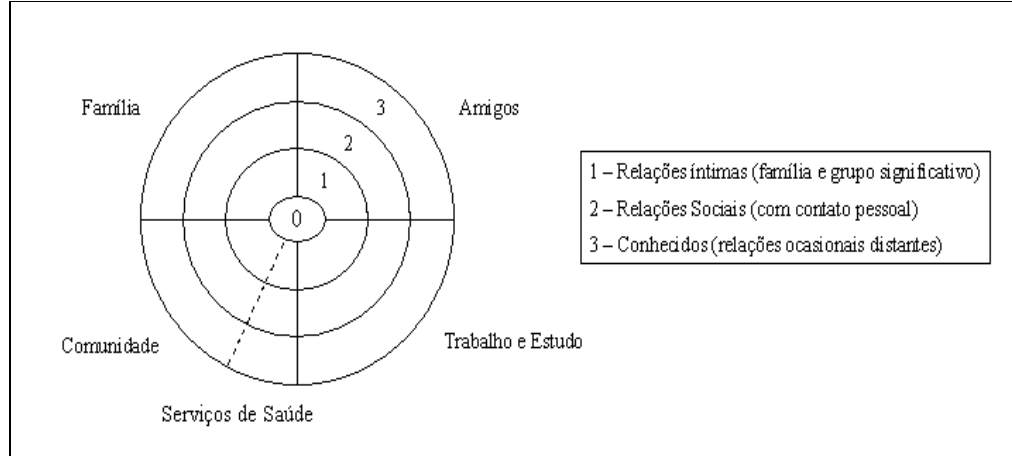
Figura 1 . Mapa de Rede proposto por Sluzki